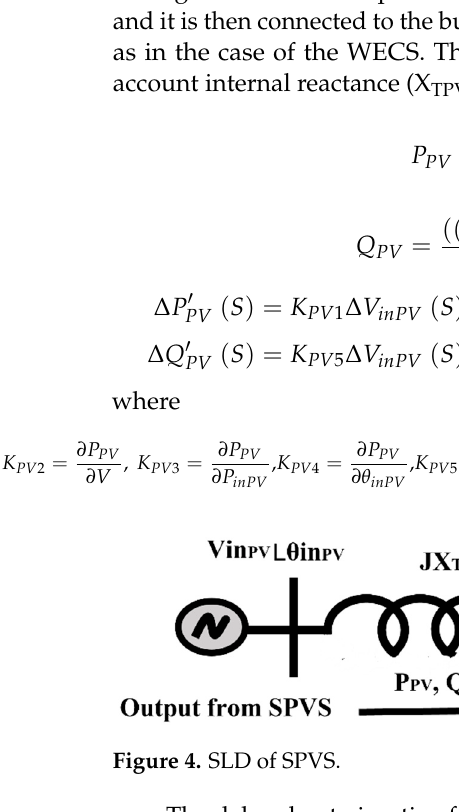
Figure 3. The block diagram of WECS.